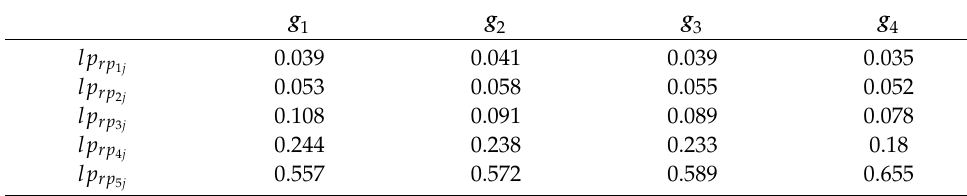
for 2019, 2020 and 2021. lj